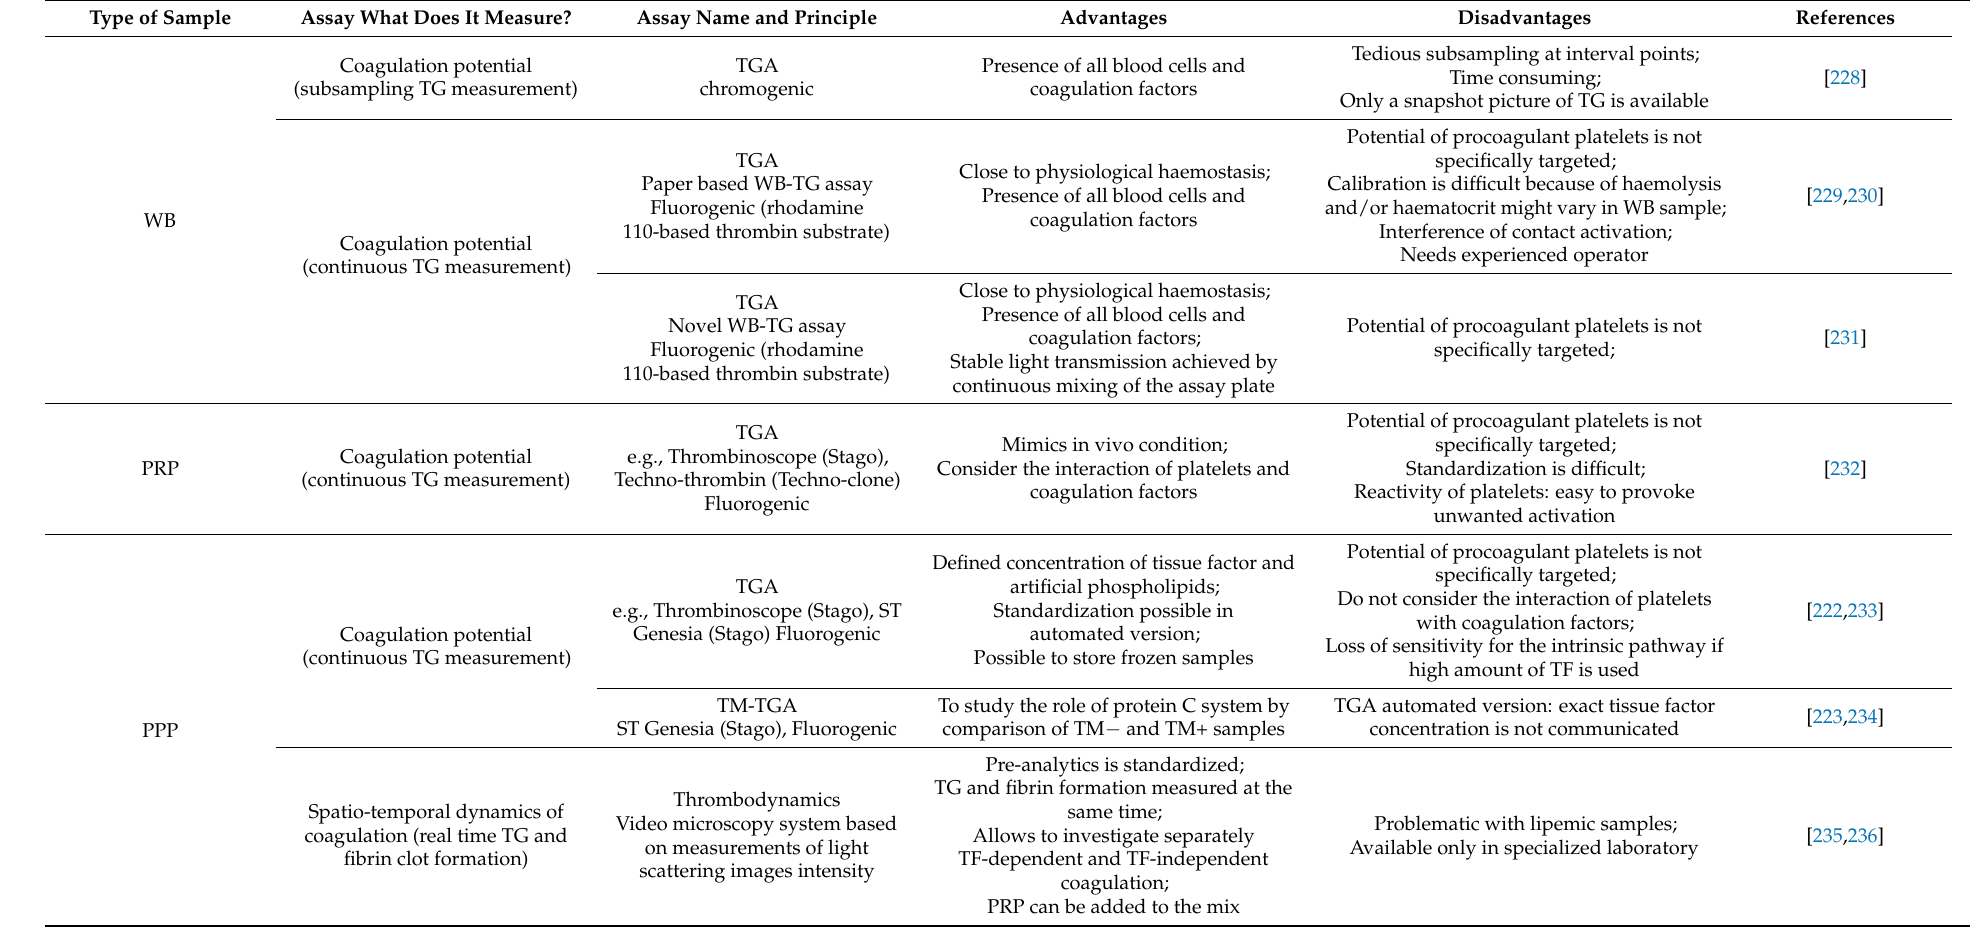
Table 2. A non-exhaustive list of techniques to assess coagulation potential and procoagulant